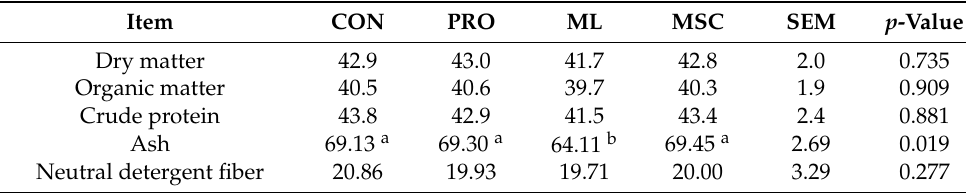
Table 2. Ruminal nutrient disappearance (percentage of supply) as affected by dietary treatment *. Item CON PRO